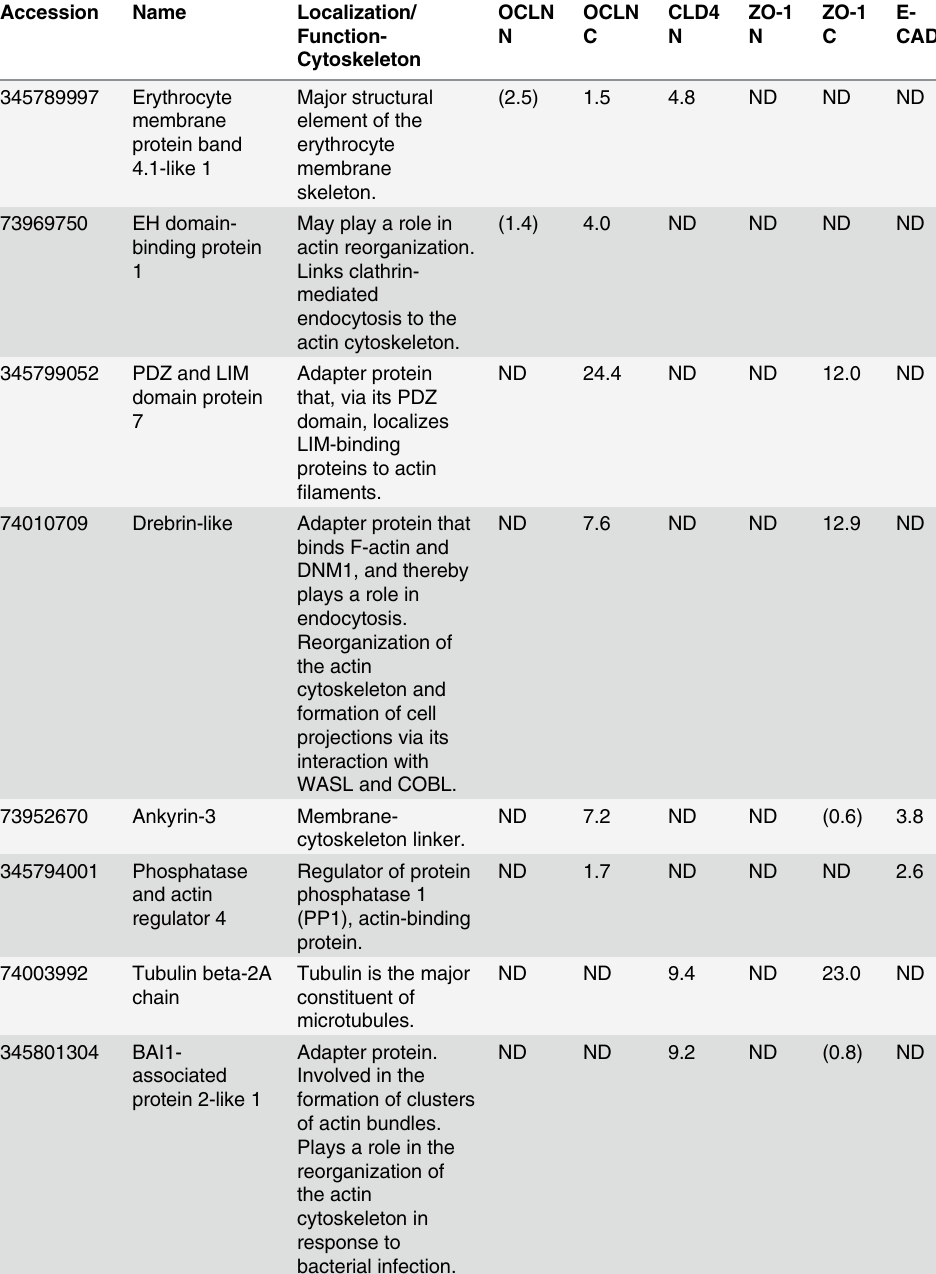
Proteins Identified with Biotin Ligase Occludin and Claudin-4 Fusion Proteins Localize to Tight Junctions and Lateral Plasma Membranes To verify that proteins biotinylated by the biotin ligase fusion proteins and identified with mass spectrometry co-localize with endogenous occludin and claudin-4, we used immunofluo- rescent techniques to visualize several novel proteins in cultured MDCK II cells,